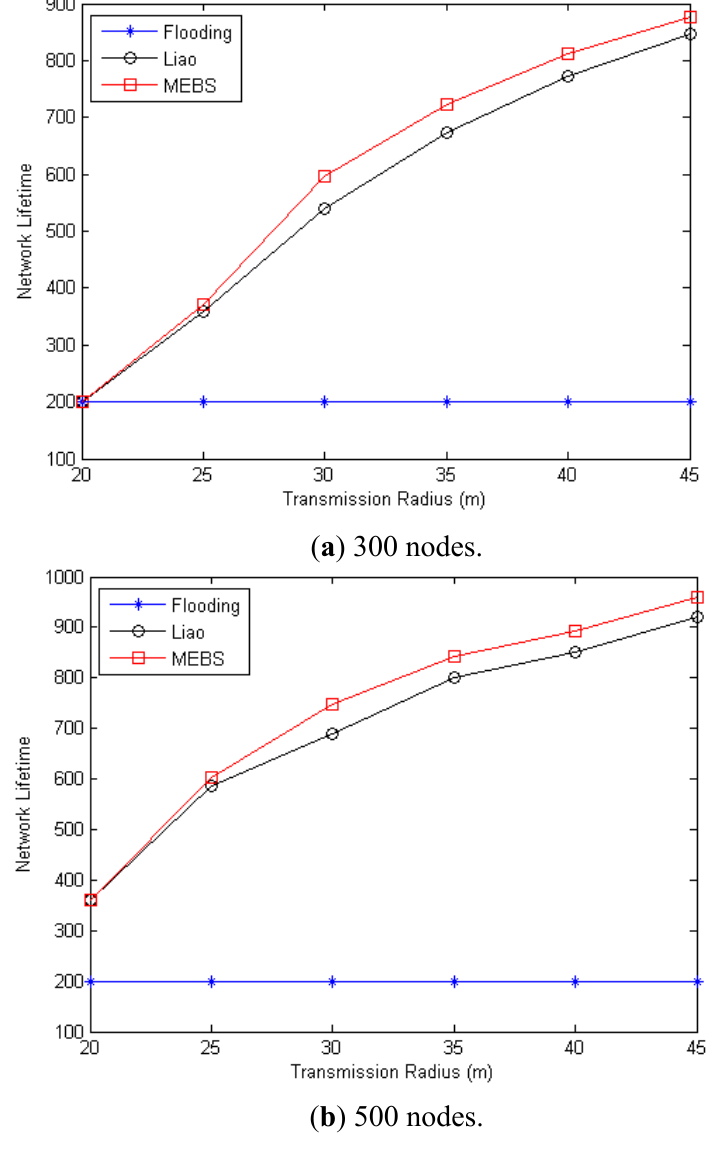
Figure 11. Network lifetime with different transmission range. ( a ) 300 nodes; ( b ) 500